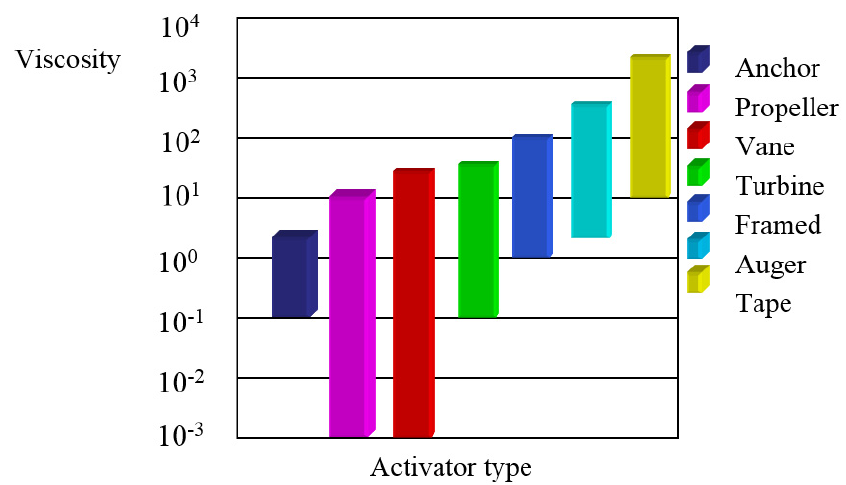
Figure 1. Selection of the type of activator depending on the viscosity of the stirred medium.